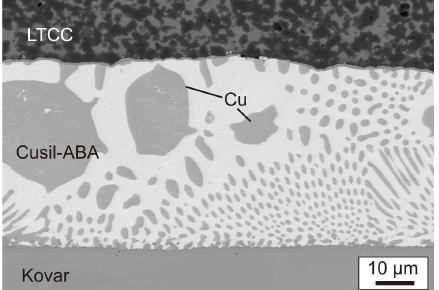
Table 2. Hermeticity after brazing with Cusil-ABA as a function of brazing parameters.